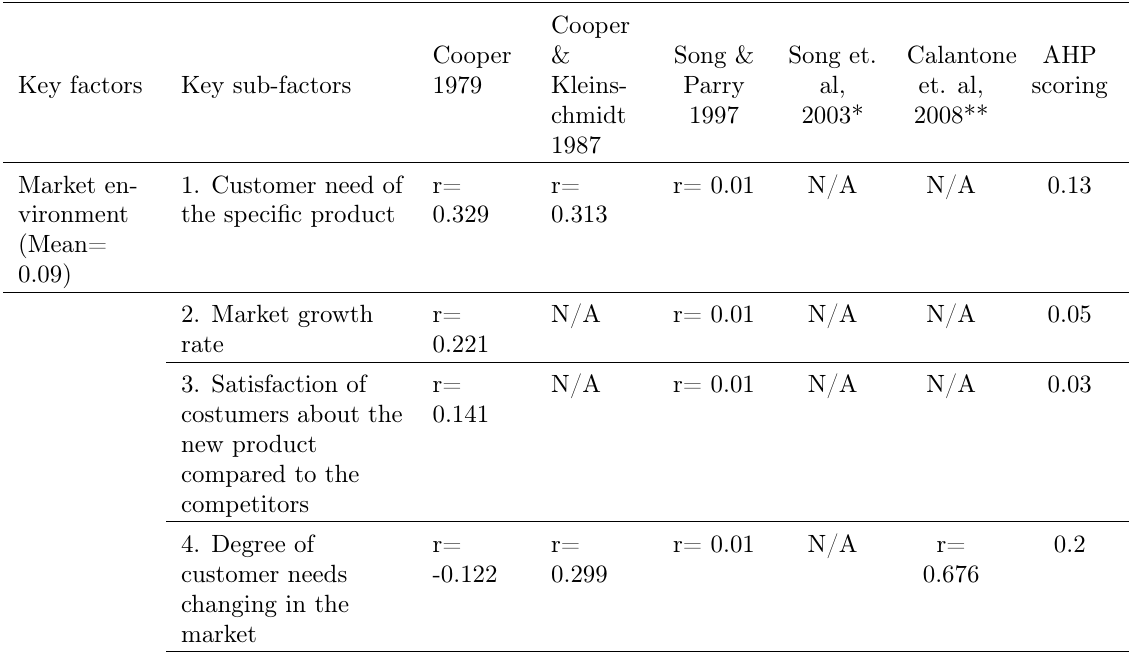
Table 1. Summary table of authors results with